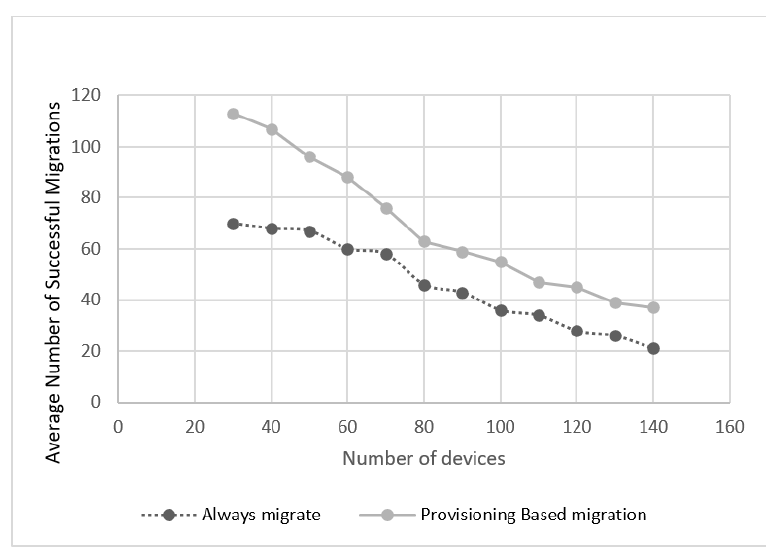
Figure 7. comparing always migrate and provisioning-based successful migrations